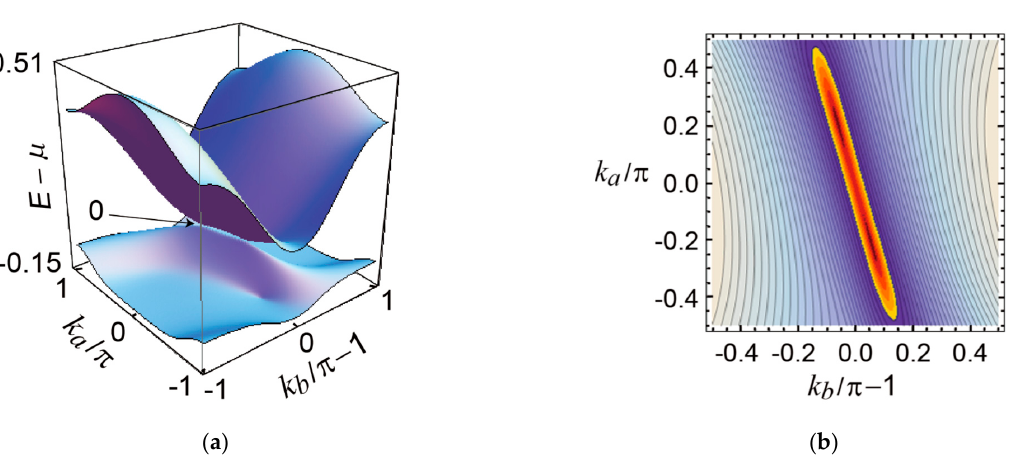
Figure 4. Intermolecular interactions between STF molecules in α -STF 2 I 3 . The unit cell contains three independent STF molecules, two halves (I and II) and one whole (III) STF molecule. All the I and II STF molecules possess an inversion centre on the central C=C bond, which means that atomic positions and electron densities are the same between Patterns 1 and 2 in Figure 2 for molecules I and II. Although molecule III does not possess an inversion centre, the atomic positions and electron densities for X in molecule III are also identical between Patterns 1 and 2.